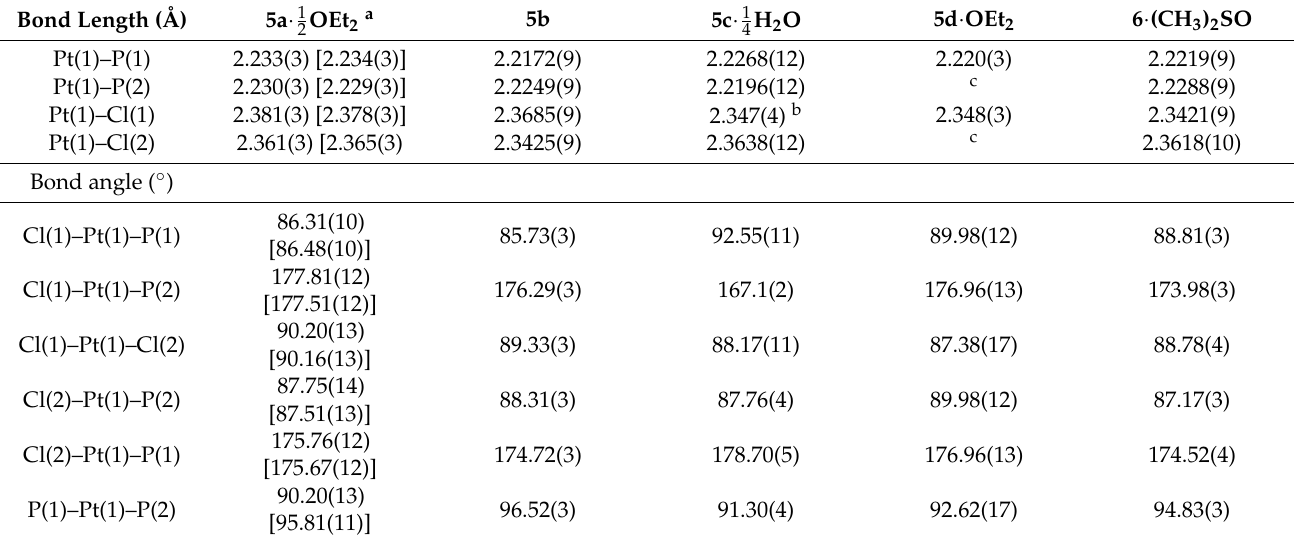
OEt 2 , 5b , 5c · 1 H 2 O , 5d · OEt 2 , and 6 · (CH 3 ) 2 SO . 2 4